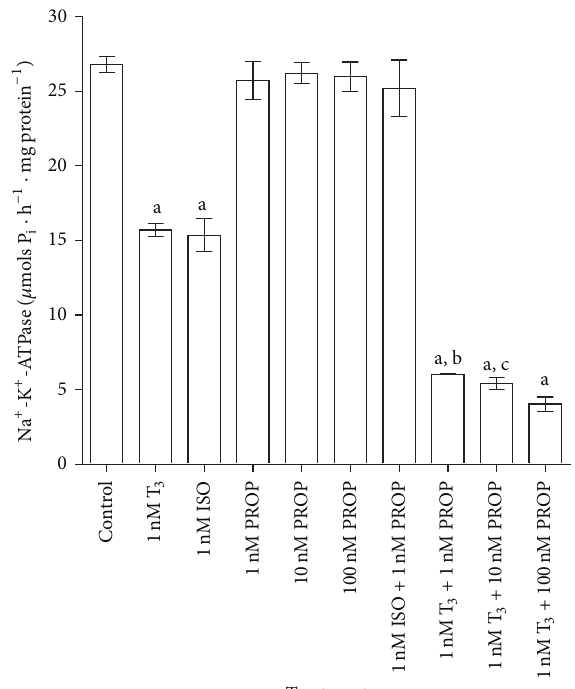
Figure 3: Effect of T 3 on synaptosomal Na + -K + -ATPase activity and its modulation by a 𝛽 -adrenergic receptor agonist (ISO) and a 𝛽 - adrenergic receptor antagonist (PROP) in vitro . A half-maximally effective dose of T 3 (1nM) was chosen from the dose-response curve for T 3 in Figure 1. The data are represented as mean ± SEM of five separate experiments taking six animals in each group. a 𝑃 < 0.001 , compared to the control group. b 𝑃 < 0.001 and c 𝑃 < 0.05 , compared to T 3 (1nM) + PROP (100nM) group (one-way ANOVA followed by Newman-Keuls test). The vertical lines denote